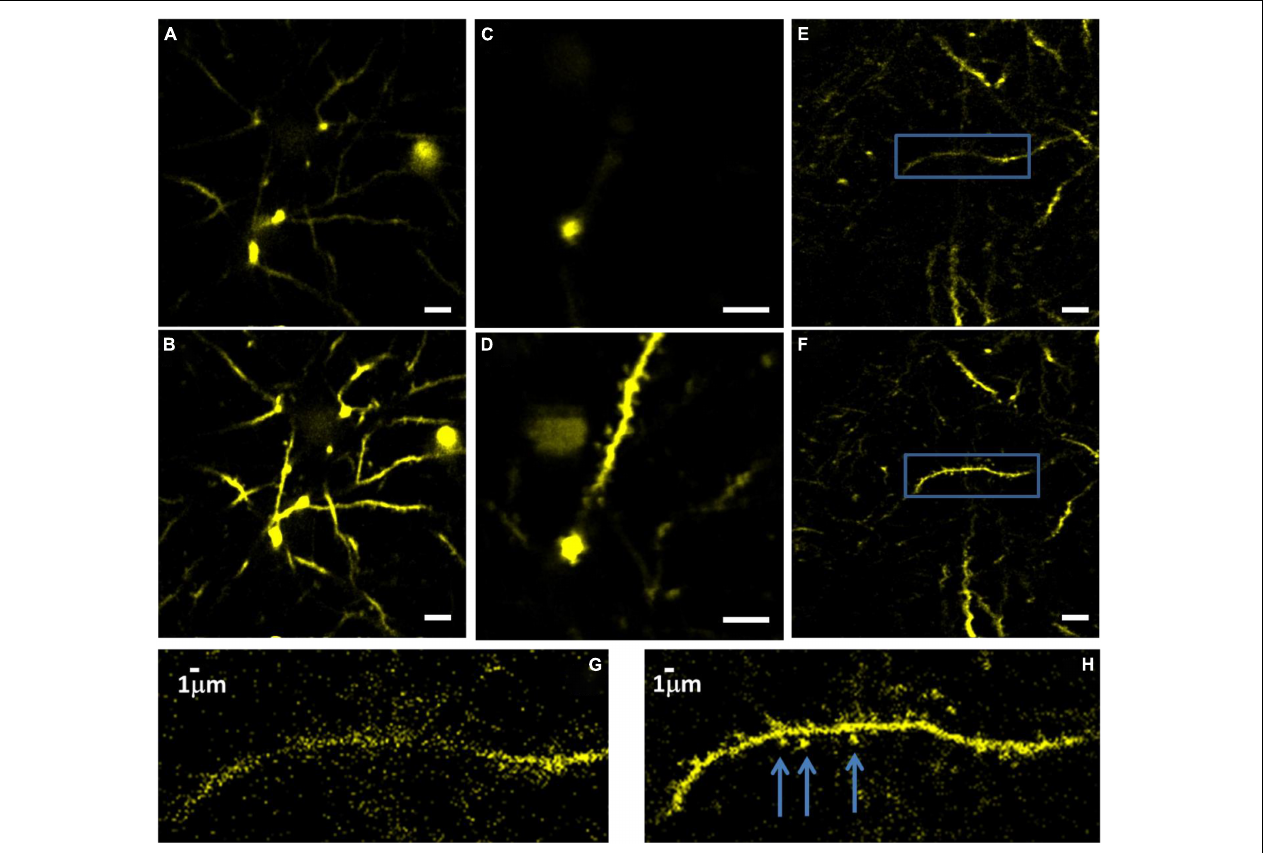
FIGURE 8 | Images of YFP labeled dendrites at 715 µ m below the surface of the brain, before (A) and (B) after correction. Imaging conditions: 15 mW with 0.5 MHz repetition rate, 110 µ m FOV. Dendrites at 600 µ m depth before (C) and after (D) correction. FOV is 55 µ m. Dendrites at 565 µ m depth before (E) and after (F) correction. FOV is 110 µ m, scale bar for panels (A–F) , 10 µ m. Panels (G,H) show zoomed-in images of the areas within the blue box in panels (E,F) , respectively. The arrows mark the dendritic spines after